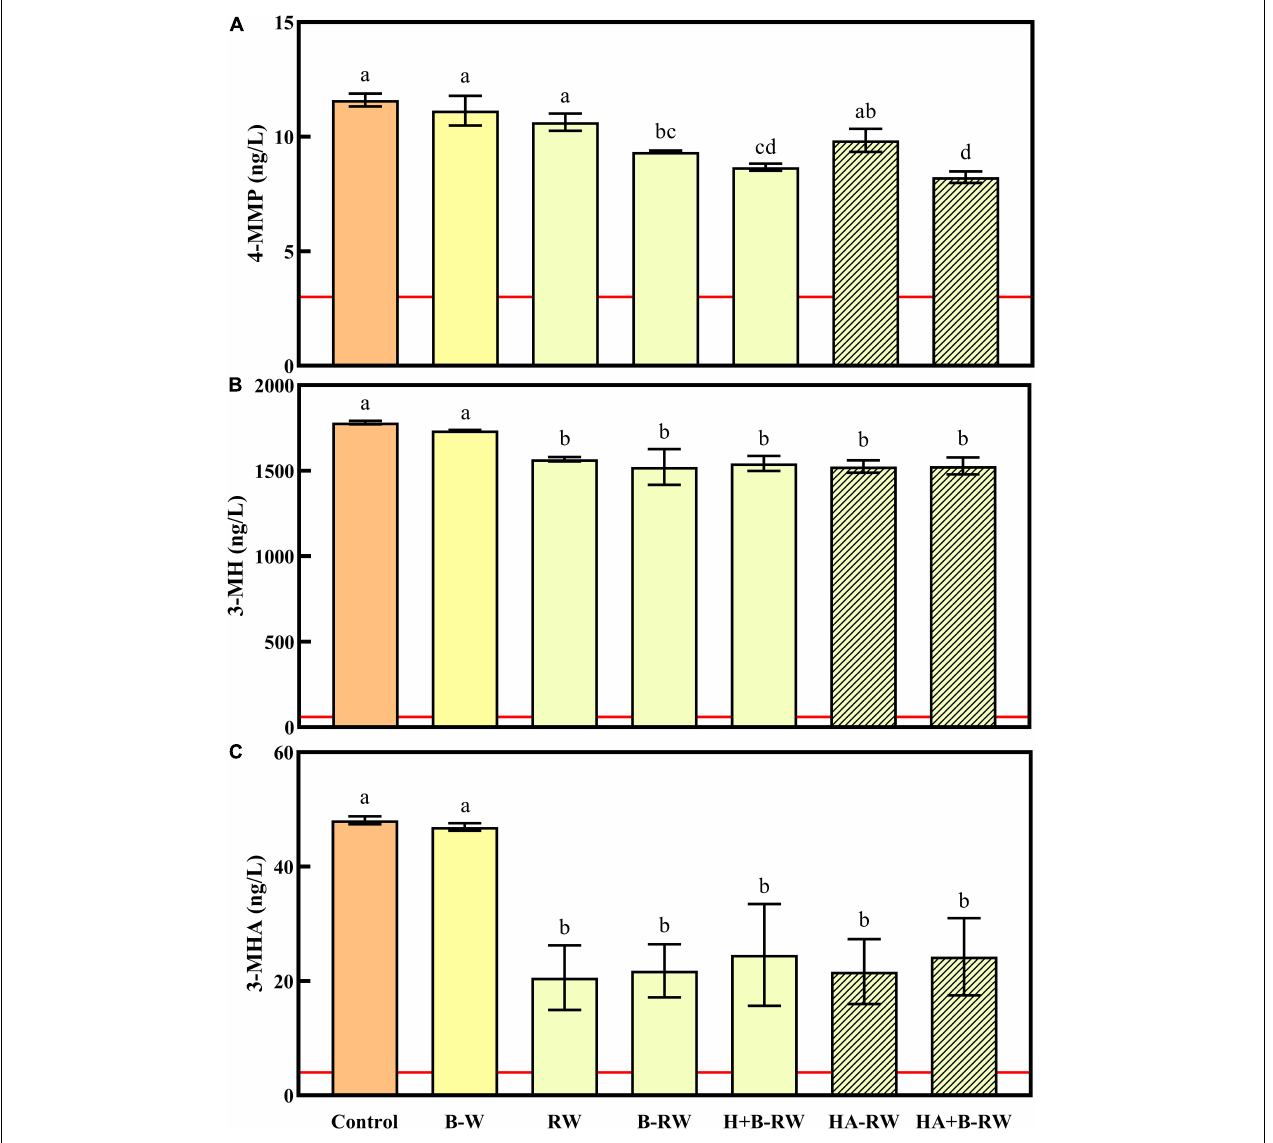
FIGURE 3 | Concentrations of (A) 4-MMP, (B) 3-MH, and (C) 3-MHA in untreated wine (Control), wine treated via bentonite fining (B-W) as a positive control, and recombined wines (RW) following ultrafiltration/heat/protease treatments; B denotes bentonite addition; H denotes heating (10 min at 62 ◦ C); A denotes Aspergillopepsin enzyme addition (DSM 0.05% v/v). The odor detection thresholds of each varietal thiol are marked as red lines. Data are means of three replicates ( ± standard error). Different letters indicate statistically significant differences (one-way ANOVA, Tukey’s HSD, P <